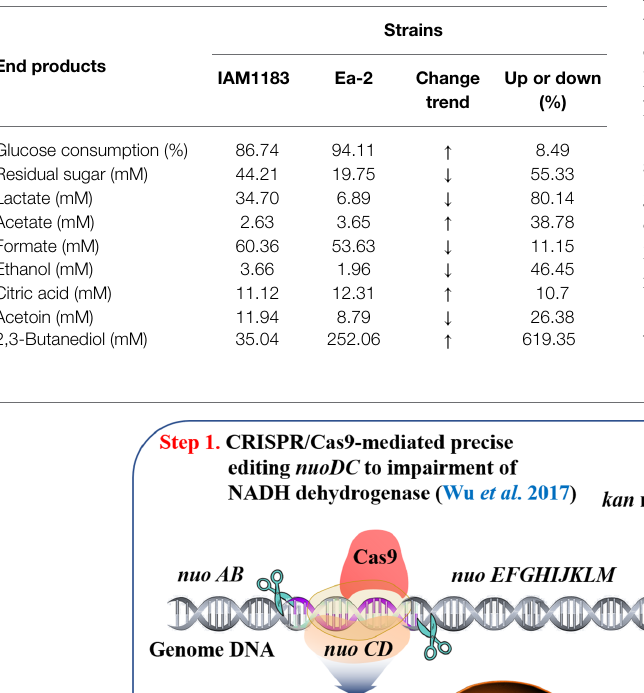
TABLE 5 | Analysis of consumed substrate and anaerobic metabolites after 44 h of cultivation of wild-type E. aerogenes IAM1183 and Ea-2 in 5-L fermenter.